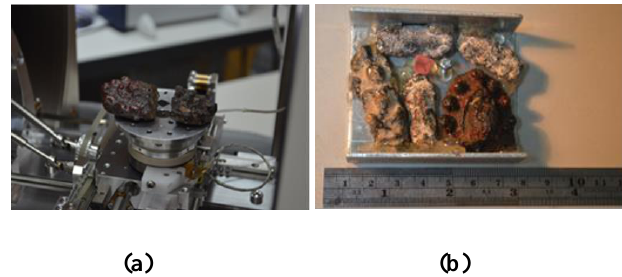
Fig. 2. Setup of samples for (a) SEM-EDS and (b) PIXE